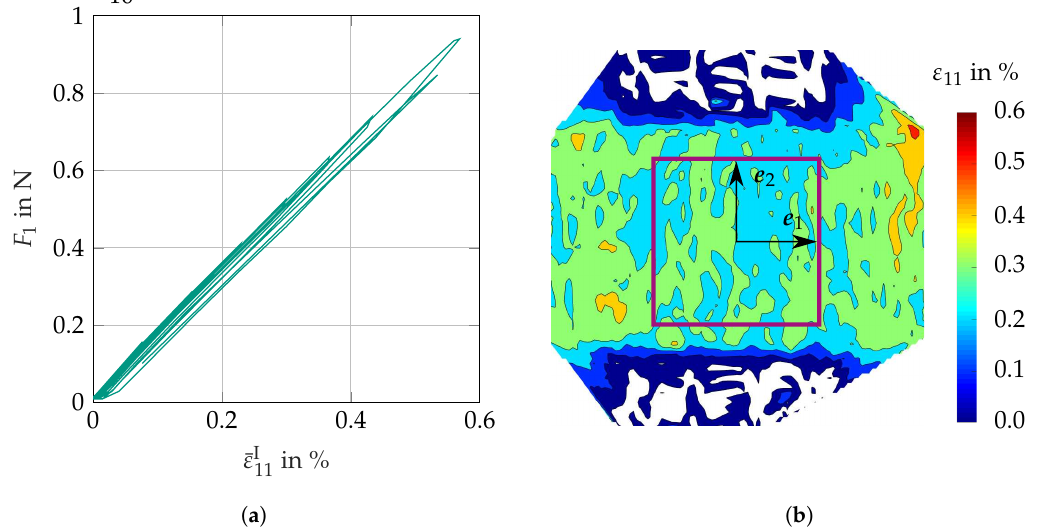
Figure 5. Unreinforced specimen arms with loading scenario P Γ = 0 . ( a ) Force F 1 in e 1 -direction over averaged normal strain ¯ ε I in the area of interest; ( b ) Contour plot of the normal strain ε 11 at ¯ ε I 11